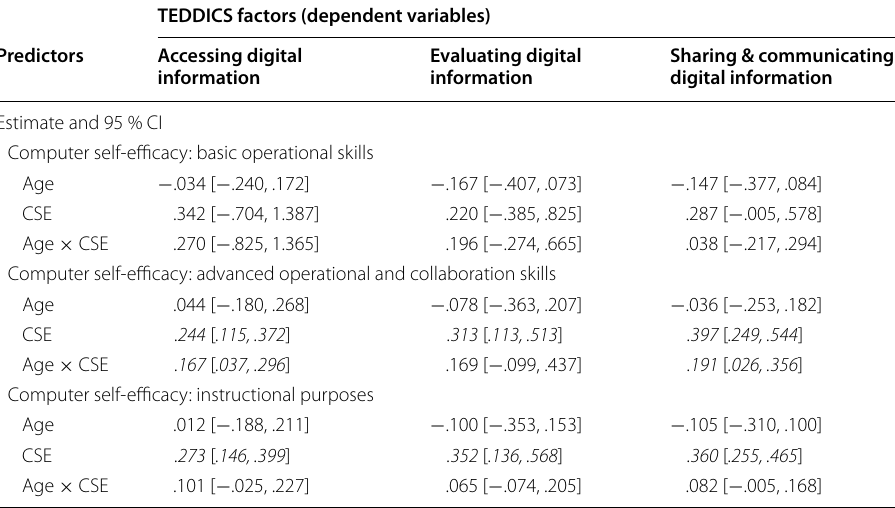
Table 5 Regression models testing the moderation effects of teachers’ age on the relation between TEDDICS and